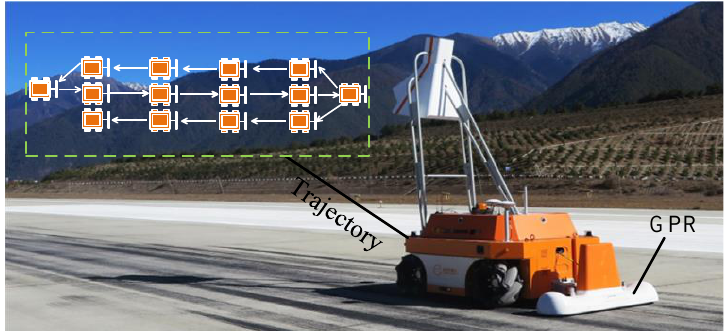
Figure 9. Our runway inspection robotic system and GPR data collection